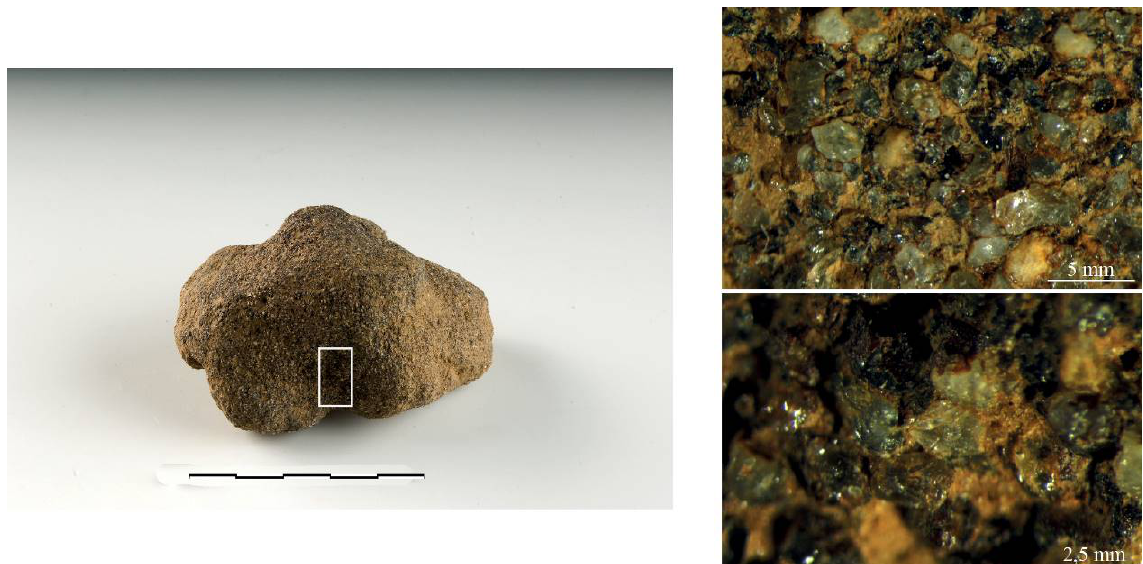
Figure 3. Grooved abrader in “roussard” sandstone found on the schist bracelet workshop in Arçonnay (Sarth). Scale bar in the left photo is 5